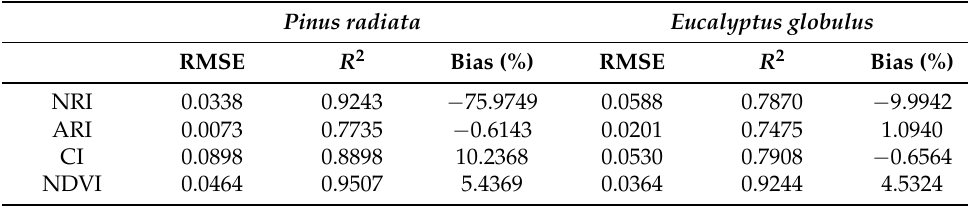
Table 5. Evaluation of Leaf Water Index (LWI) to retrieve non-water content related vegetation indices